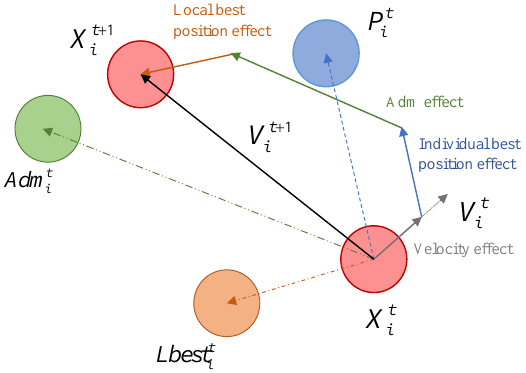
Figure 1. The update of particle positions in two successive iterations (i.e., t to t + 1 ).